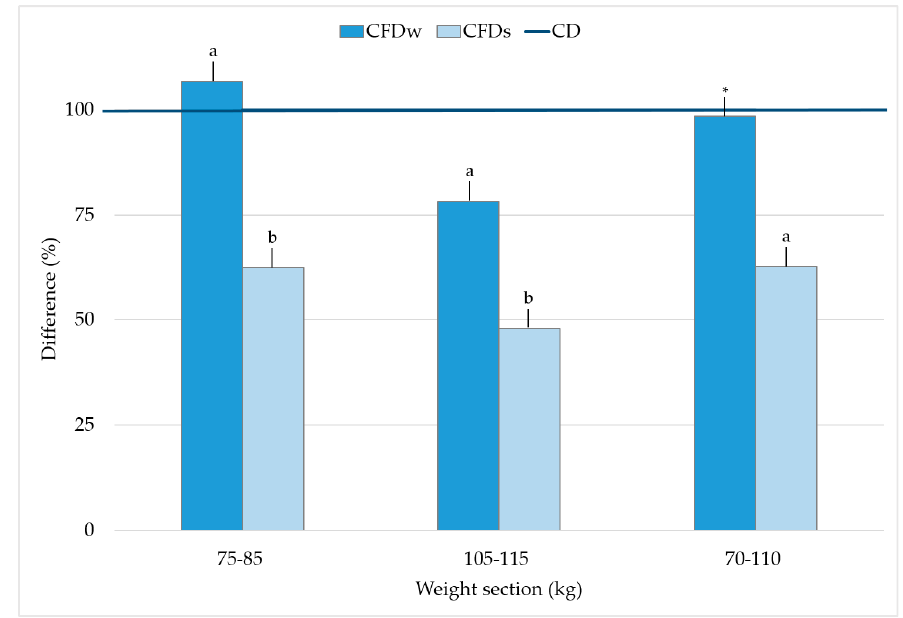
Figure 6. Percentual difference of mean ammonia concentrations measured in the exhaust air for CFD W and CFD S in relation to CD (defined as 100%). a and b significantly differ from CD; * no significant difference from CD.